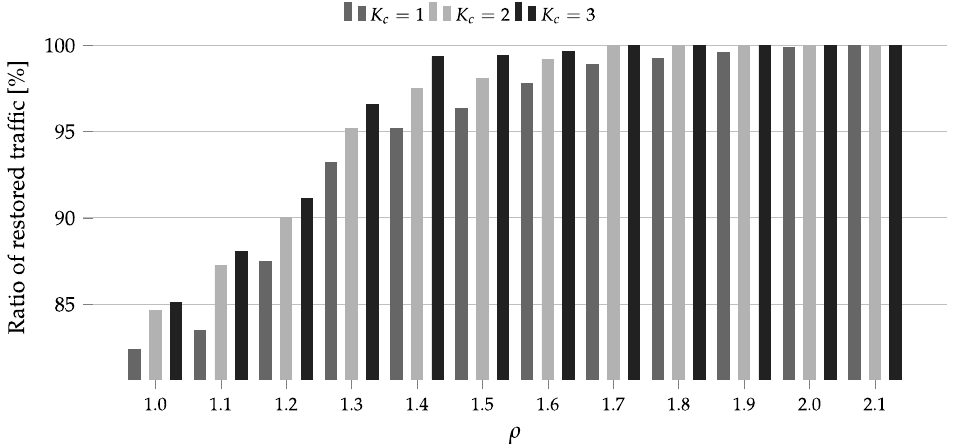
Figure 8. Ratio of the restored traffic for DT14 and 25 Tbps as a function of the amount of additional resources ρ